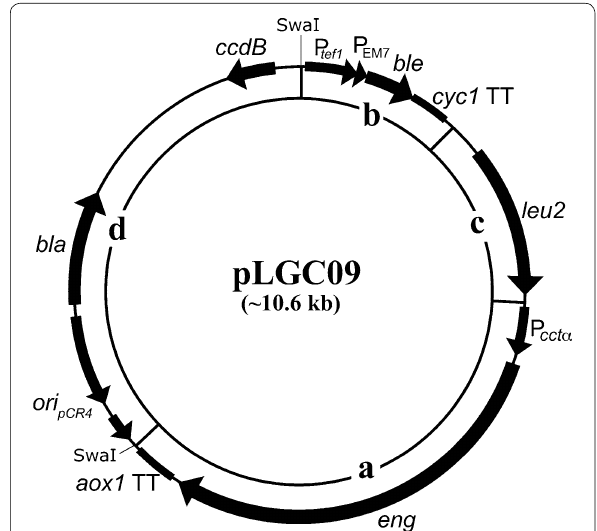
Fig. 1 Structure of pLGC09. Plasmid pLGC09 comprises three modules: a the lytic regulated module is composed of the promoter of chaperonin CCT one complex (P cct α) that drives expression of eng in P. pastoris and it is finished by aox1 transcription termination ( aox1 TT) region; b the selection marker module is composed of the translational elongation factor 1 gene promoter (P tef1 ) and of the EM7 synthetic prokaryotic promoter (P EM7 ) that drive expression of the ble gene in P. pastoris and E. coli respectively, these expressions are finished by cyc1 transcription termination region ( cyc1 TT); c the homologous recombination module is composed of the leu2 functional gene including its promoter and transcription termination region; and d the replicon pCR ® 4Blunt‑TOPO ® that includes the functional gene bla and pUC origin ( ori pUC Table 2 was corrected, including the sequences of the primers used to construct pLGC09. These corrections do not alter any conclusions or results of our study.